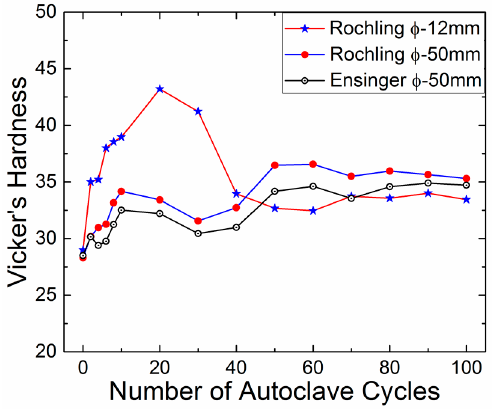
Figure 6. Effect of rod size on the hardness variation with respect to autoclave cycles.